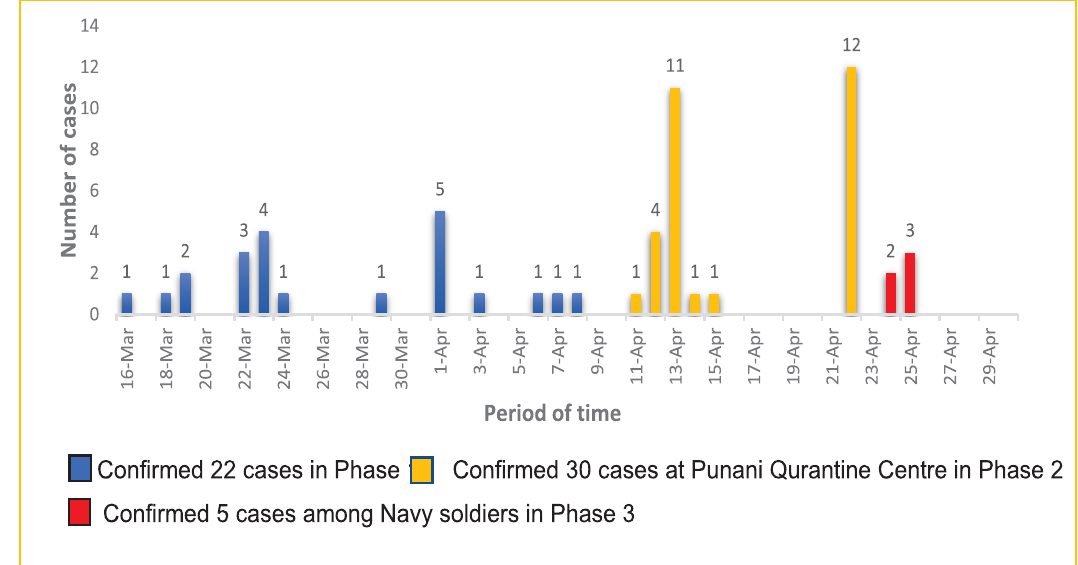
Figure 1: Distribution of confirmed cases from NIHS Field Practice Area (16 March-29